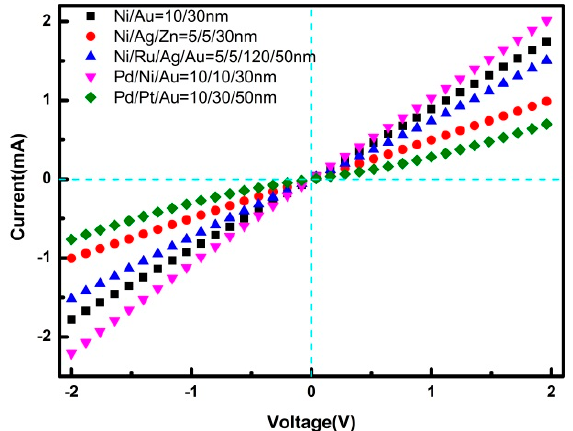
Figure 3. Measured I – V curves for five different contact metallizations to p-GaN on GaN laser diode, after annealing in a different atmosphere for 5 min at similar temperature.